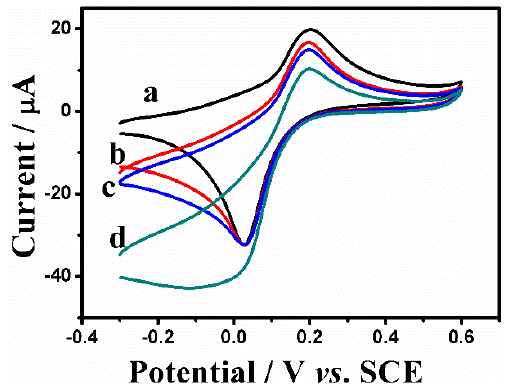
Figure 5. CVs of magnetite PB nano-composites modified GCE in the absence ( a ) and presence of 1 mM ( b ), 2 mM ( c ), and 4 mM H 2 O 2 ( d ) in 0.1 M PBS (pH 6.0) with the scan rate of 100 mV ∙ s − 1 .